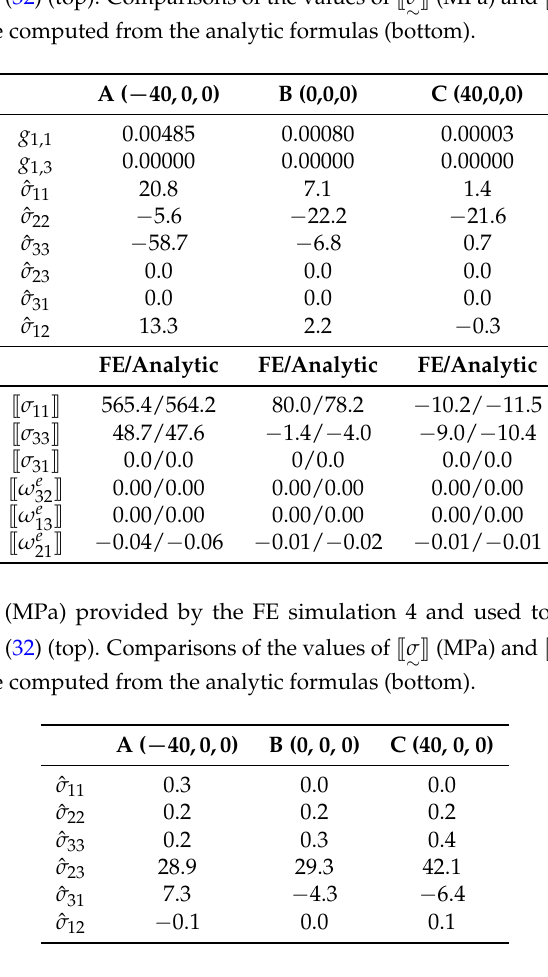
]] (MPa) and [[ ω e ]] ( ◦ ) given by the FE ∼ ∼